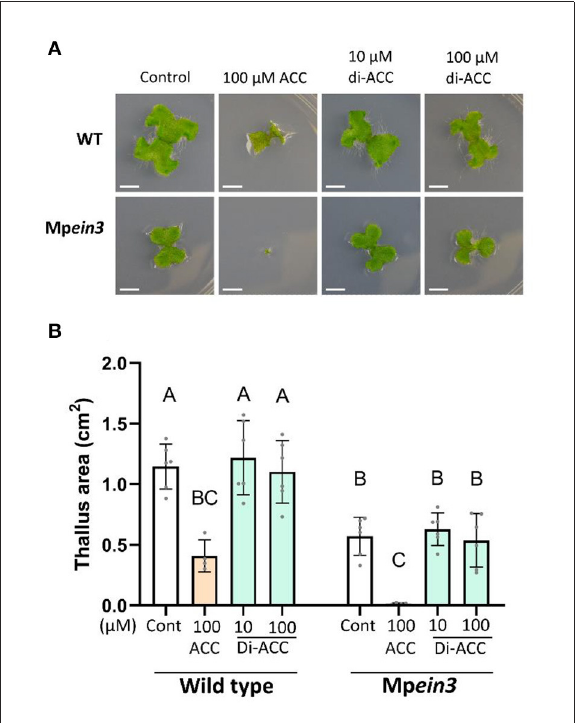
FIGURE3 The ACC dimer does not induce ethylene-independent ACC signaling in Marchantia . (A) Representative images and (B) quantification of Marchantia polymorpha ground cover in WT and Mp ein3 plants, after ACC or di-ACC treatment ( n ≥ 4). Scale bars are